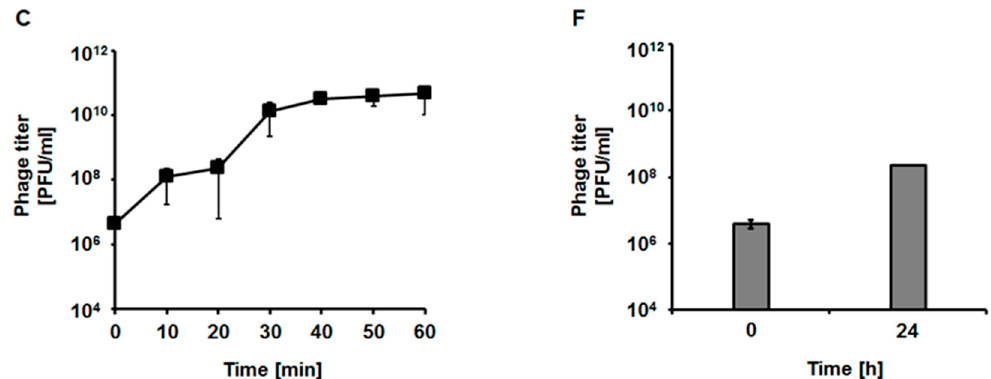
Figure 5. The lysis profile of host bacteria after infection of E. faecalis 271 (black squares and columns; Panels A – C ) and 272 (gray squares and columns; Panels D – F ) with the vB_EfaS-271 bacteriophage at an M.O.I. of 0.05. The results are presented as the bacterial culture density measured spectrophotometrically at OD 600 ( A ), the number of bacterial cells surviving the phage infection per 1 mL (CFU / mL) ( B ) and the number of phages per 1 mL (PFU / mL) ( C ). The results are shown as the mean values ± SD from three biological experiments. Note that in some cases the error bars are smaller than sizes of symbols.